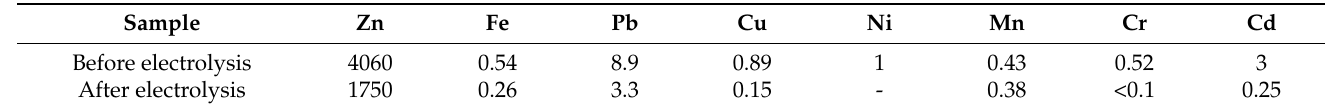
Table 11. Chemical composition of the electrolyte before and after the electrolysis process—AAS analysis (mL/L); input sludge—B21